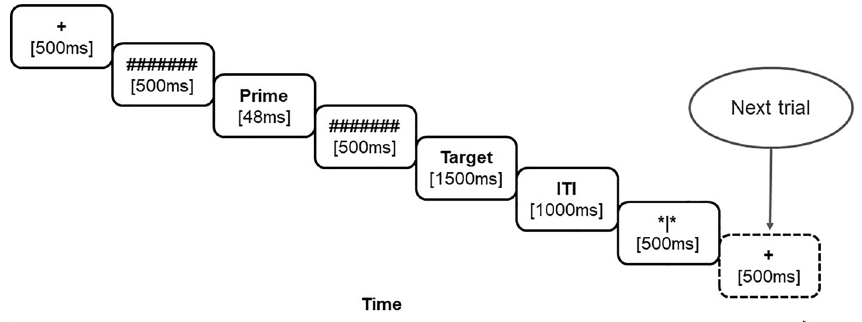
Figure 3. Scheme of an experimental